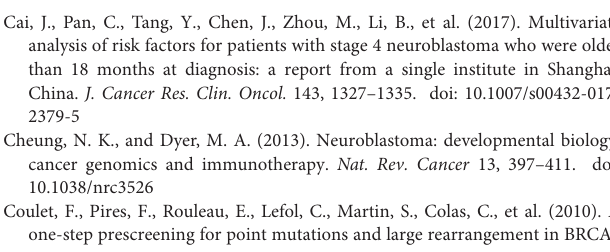
GSE62564 dataset. Supplementary Figure 2 | KEGG pathway enrichment analysis of differentially expressed genes between BRCA2-P/CAF high group and BRCA2-P/CAF low group from GSE62564 dataset. Supplementary Figure 3 | KEGG pathway enrichment analysis of specific somatic variants. (A) KEGG pathway enrichment of 721 individual mutant genes in elder sister. (B) KEGG pathway enrichment of 701 individual mutant genes in brother. Supplementary Figure 4 | Expression of BRCA2 in the siblings. Real-time PCR to detect expression of BRCA2 in the siblings’ RNA from tumor